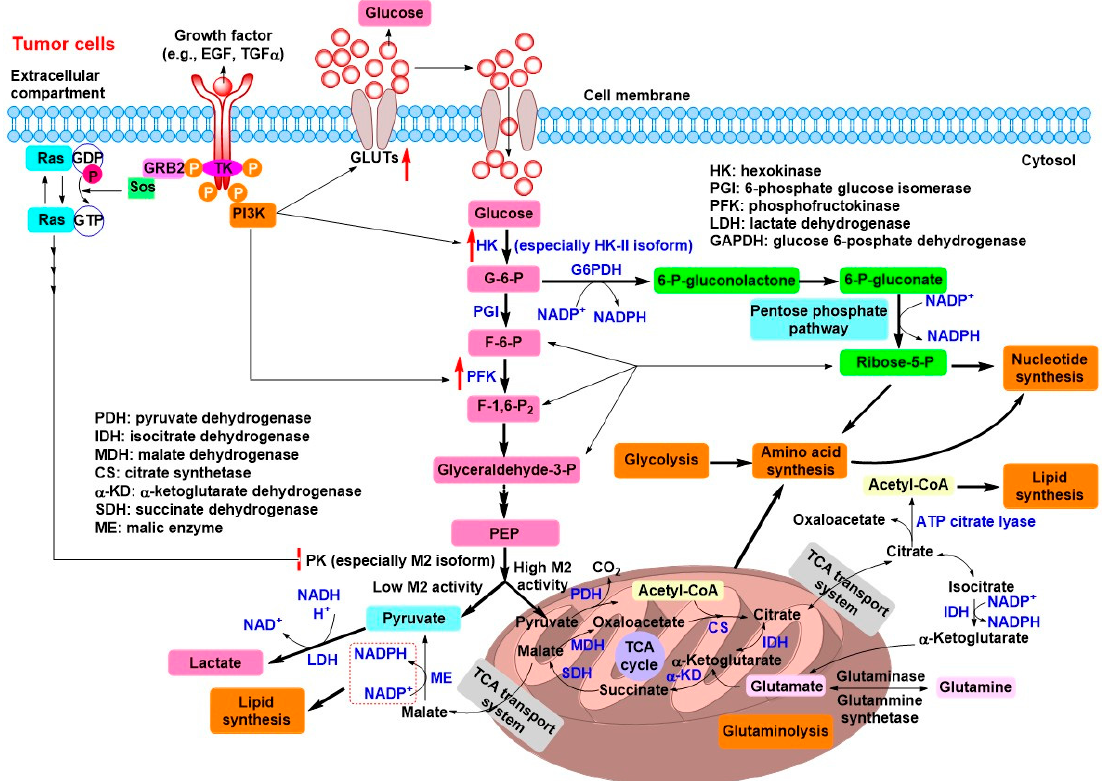
Figure 2. Schematic representation of metabolism in tumor cells. Mutation-mediated continuous activation of PI3K/AKT signaling pathway upregulates the expression of glucose transporters (GLUTs) and substantially enhances the capture of glucose into the cytoplasm by HK, and activates PFK or upregulates PFK expression, leading to the high rate of glucose influx, which in turn facilitates the aerobic glycolysis. The glycolytic switch in tumor cells allows the direct or indirect flux of glycolytic intermediates to many biosynthetic pathways (e.g., PPP, amino acid synthesis, lipid synthesis, and nucleotide synthesis), which provides the biomacromolecules and other materials required for producing new daughter cells. In addition, the intermediates of glutaminolysis are also used for synthesizing biomass that rapidly growing tumor cells need.